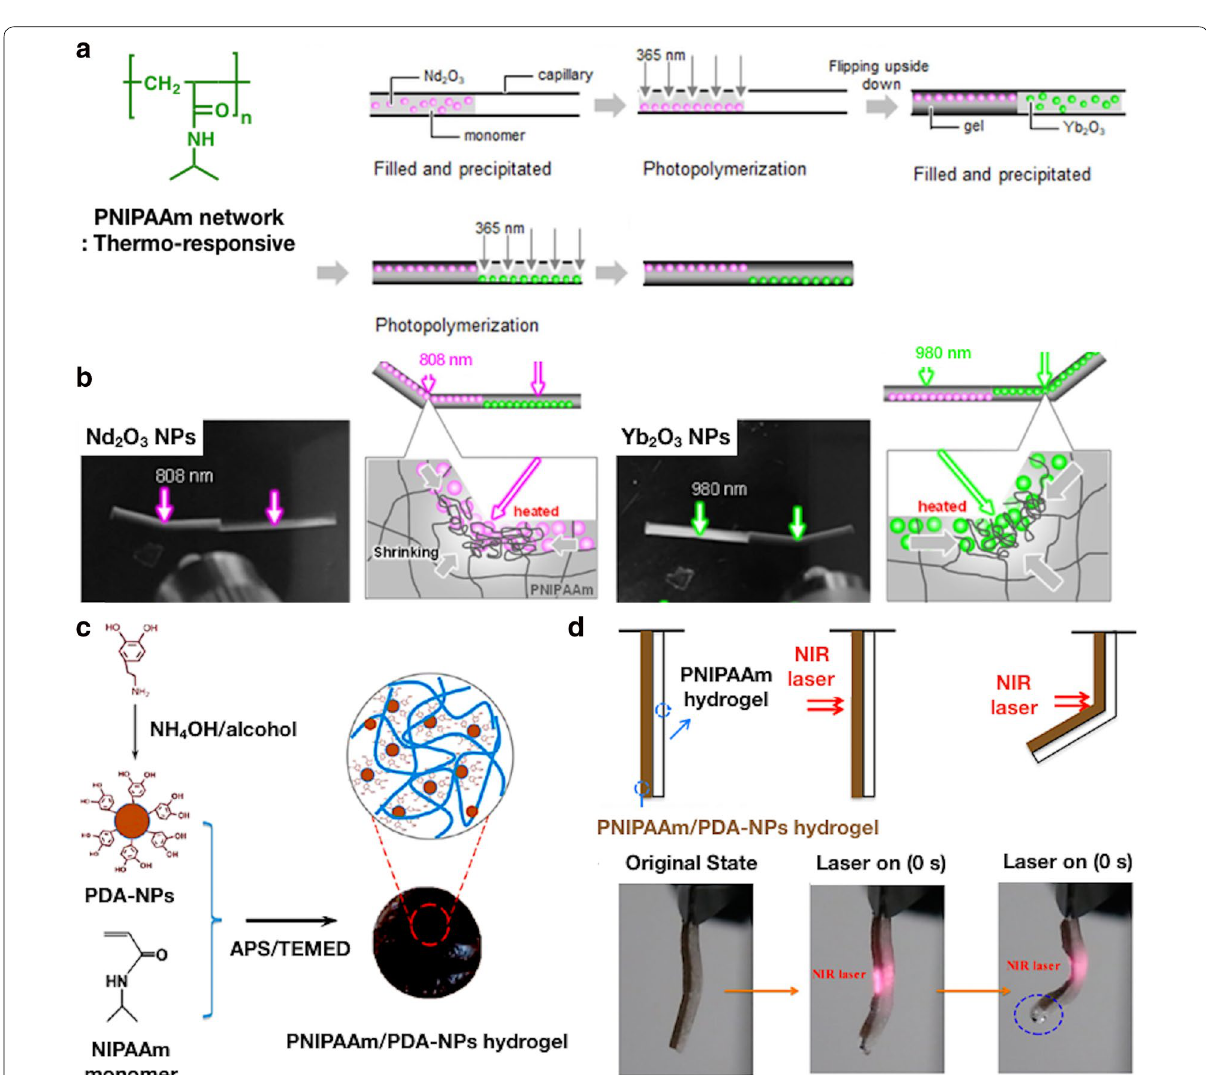
Fig. 4 a Schematic of the synthesis of REO NPs combined with rod shaped hydrogels for bending actuation. b Images of the as-prepared rod shaped hydrogels with 808 nm (Nd 2 O 3 NPs selective absorbance) and 980 nm (Yb 2 O 3 NPs selective absorbance) irradiation demonstrating the bending actuation. This NIR light irradiation exploited at 3 W/cm 2 for 60 s at 28 °C. ( a , b were reproduced with permission from Ref. [39], © 2018, Inc. The Authors; published by Springer Nature). c Schematic of the synthesis of PNIPAAm/PDA-NPs hydrogel by the oxidative self-polymerization of PDA-NPs and free radical polymerization of PNIPAAm. d Bending motion of the bilayered hydrogel actuator, composed of PNIPAAm/PDA-NPs and PNIPAAm hydrogel layers, upon NIR laser irradiation. ( c , d were reproduced with permission from Ref. [40] © 2016, American Chemical